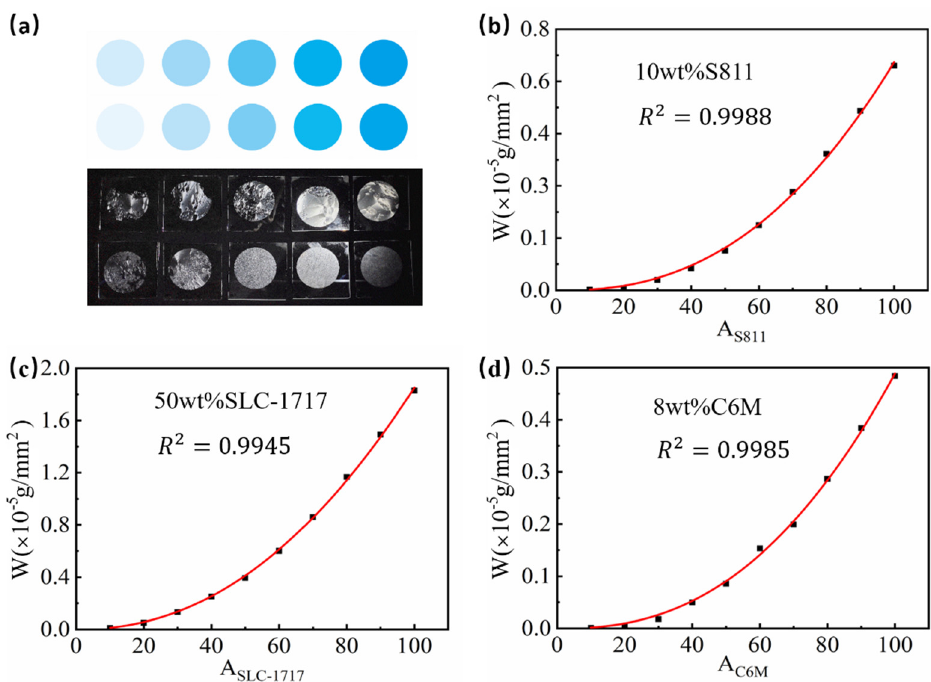
Figure 3. ( a ) Cyan patterns with colorimetric value; ( b ) the “standard curves” of S811 ink; ( c ) the “standard curves” of SLC − 1717 ink; ( d ) the “standard curves” of C6M